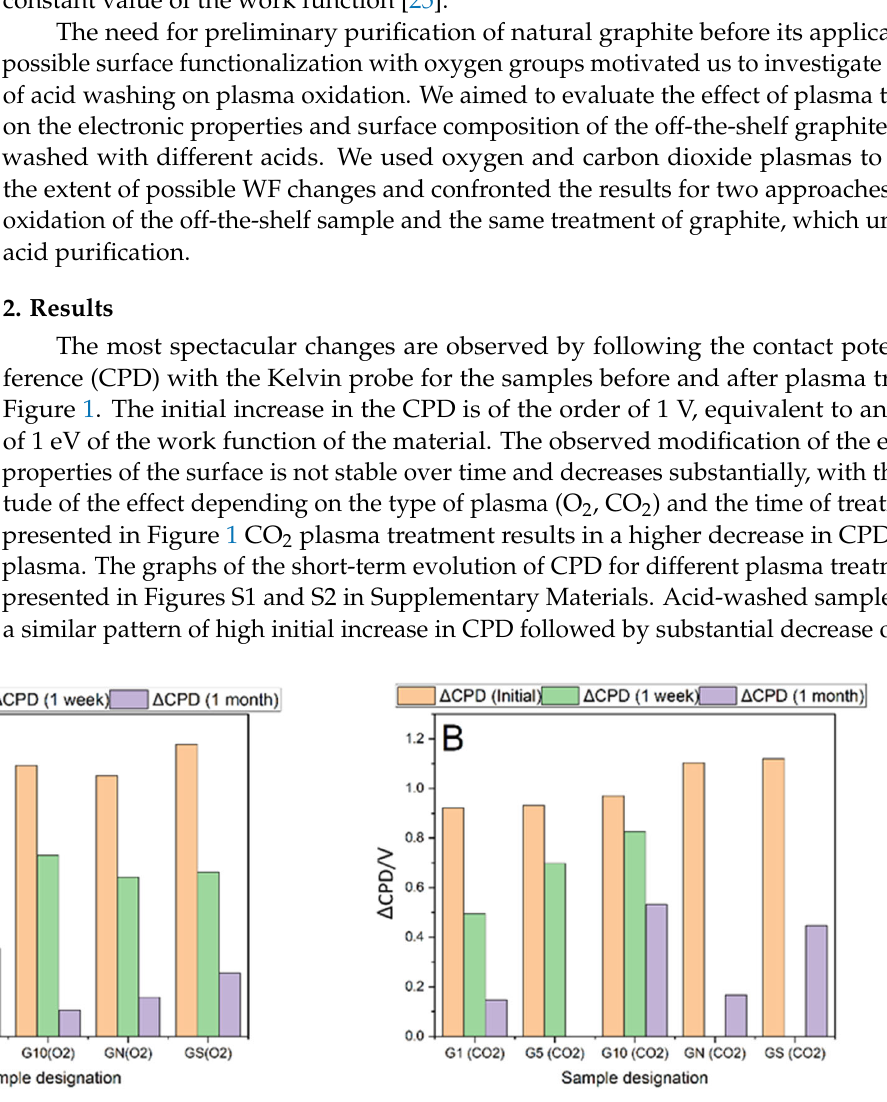
CPD) relative to the starting material (Figure